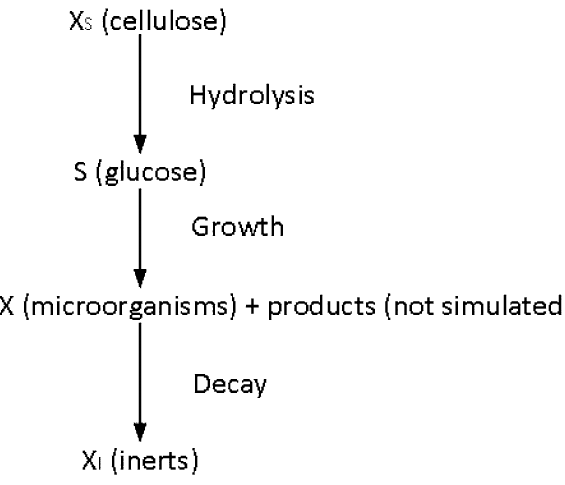
Fig. 1 Conceptual scheme of the model used in this